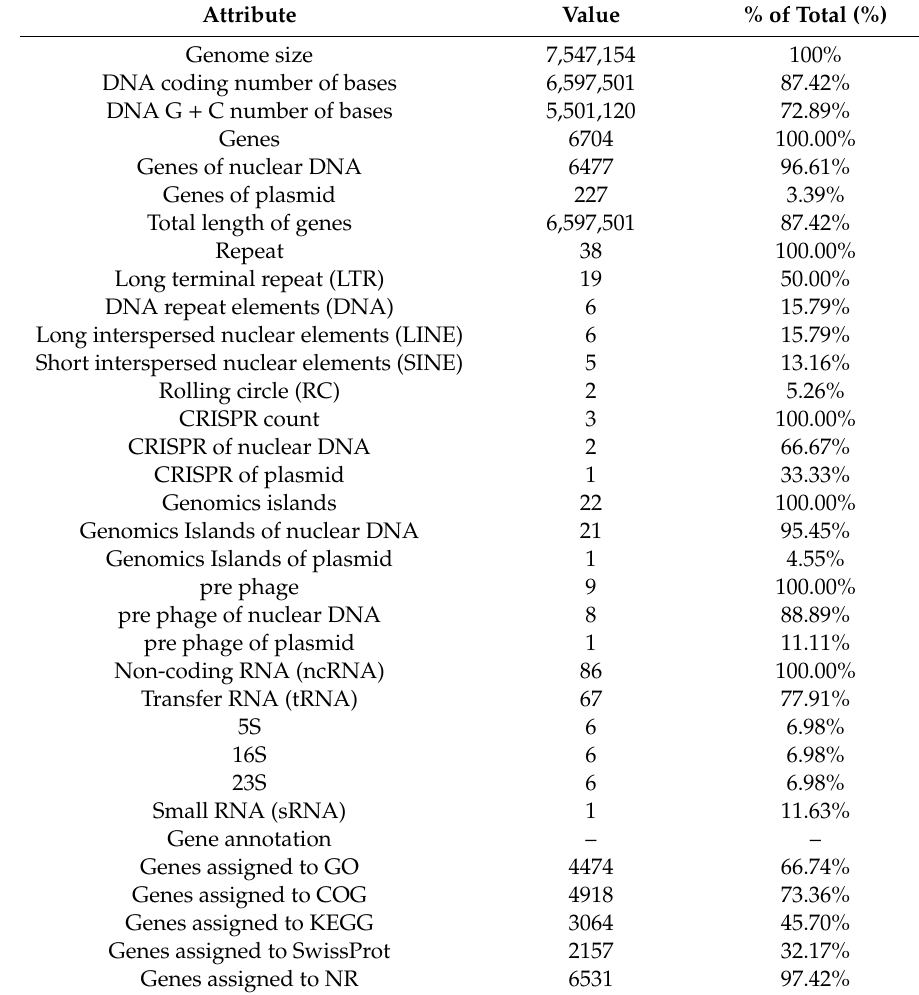
Table 2. General features associated with the genome in S. albogriseolus